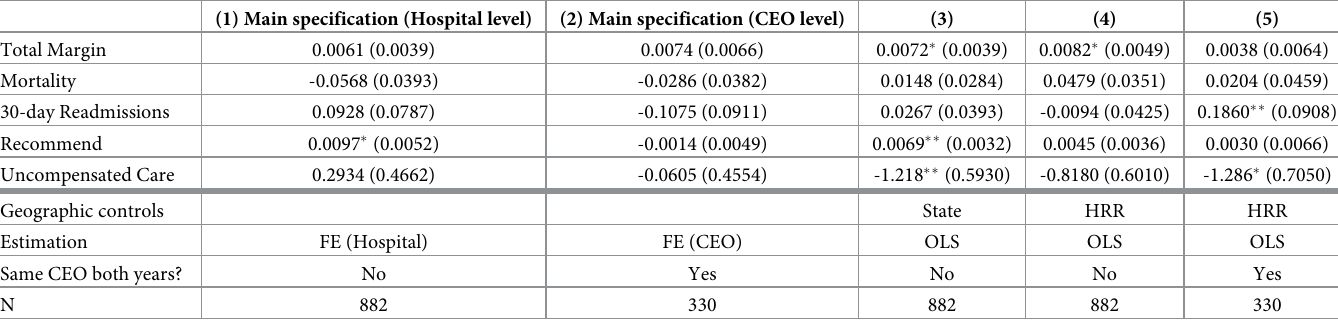
Table 4. Alternative estimation results: Effect of hospital performance measures on CEO